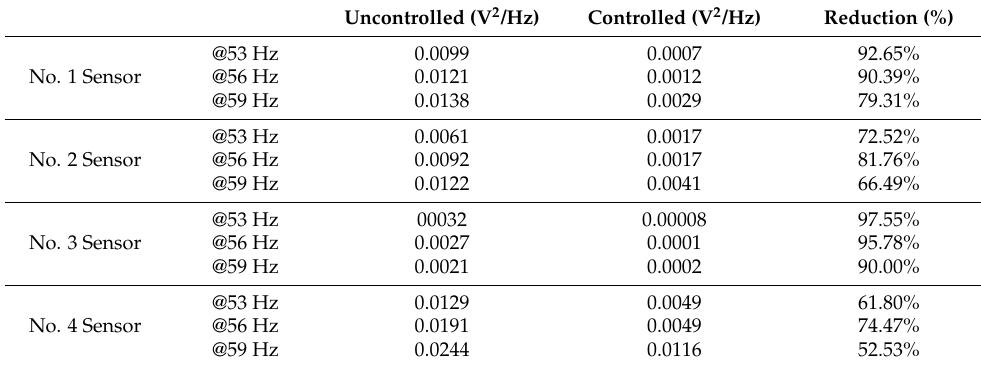
Figure 19. PSDs of sensor signals obtained by experiments. Table 8. Peak values of PSD curves of sensor signals: Experiment